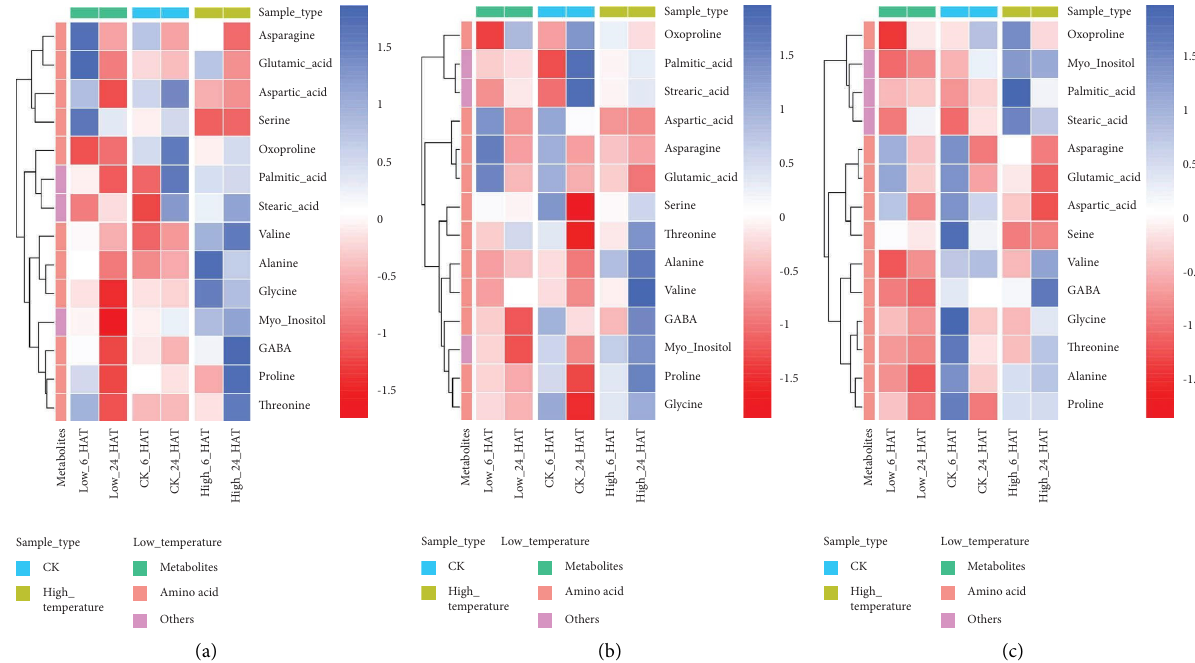
Figure 4: Efects of diferent temperature treatments on amino acid content in the pulp (a), favedo (b), and albedo (c) of Valencia orange fruits. Te content of each metabolite was scaled by row with the Z -score method. In the color key, the blue color indicates a high expression level, and the red color indicates a low expression level.